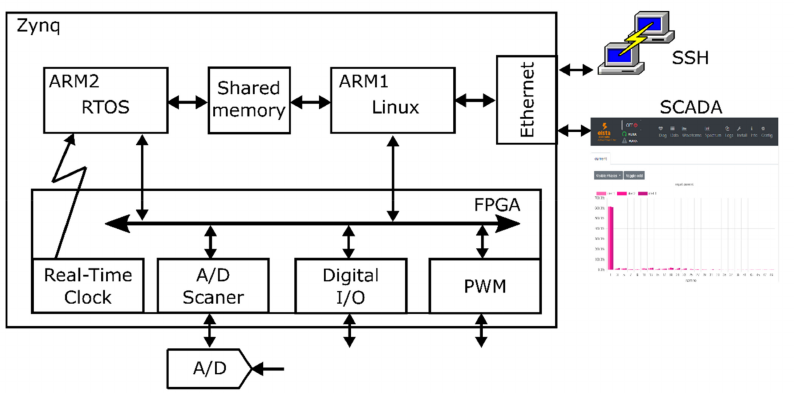
Figure 5. Architecture of the S-APF controller.